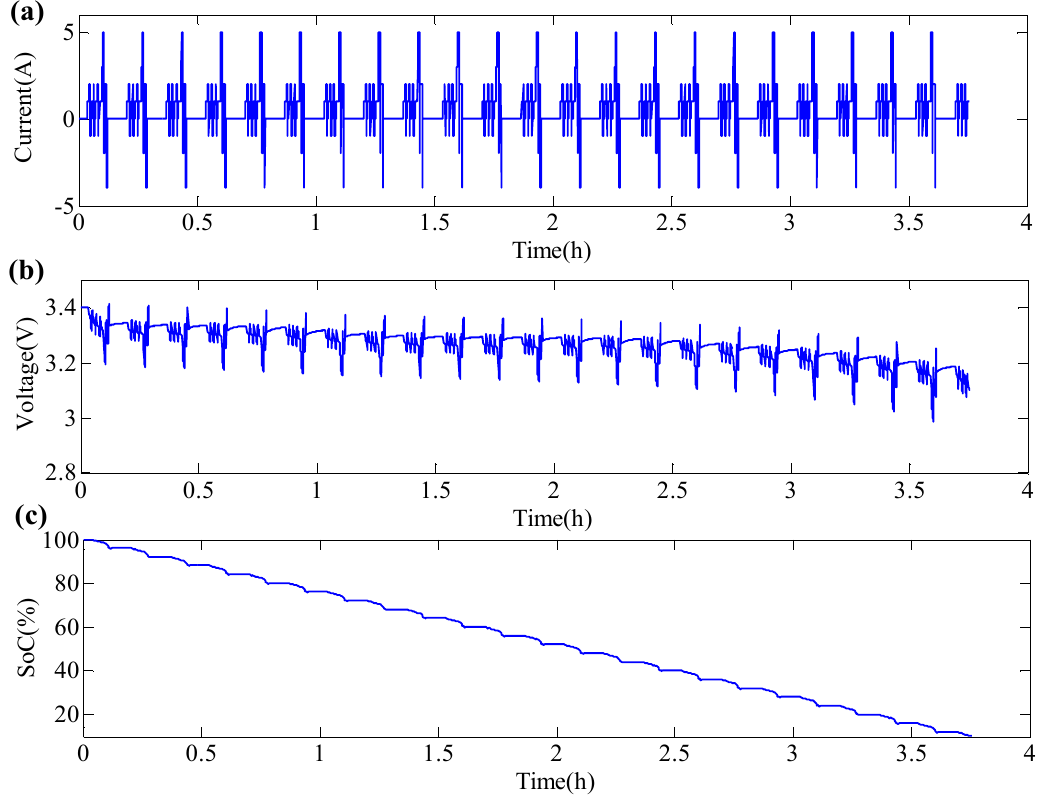
Figure 7. The dynamic stress test of the LiFePO 4 cell: ( a ) Current; ( b ) Voltage; ( c )